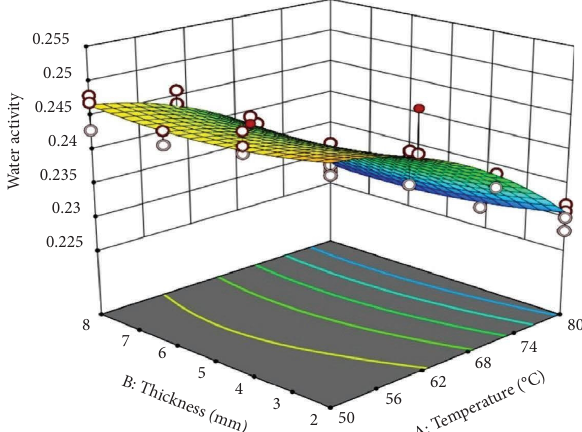
Figure 2: Infuence of tray-drying conditions on water activity (a of banana four.